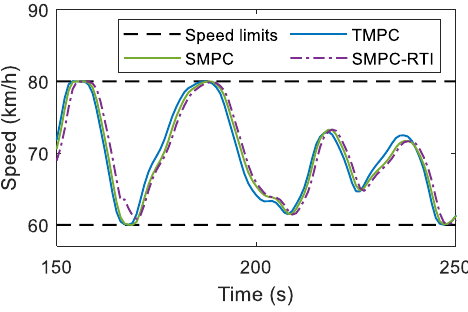
Figure 10. Comparison between three MPCs.